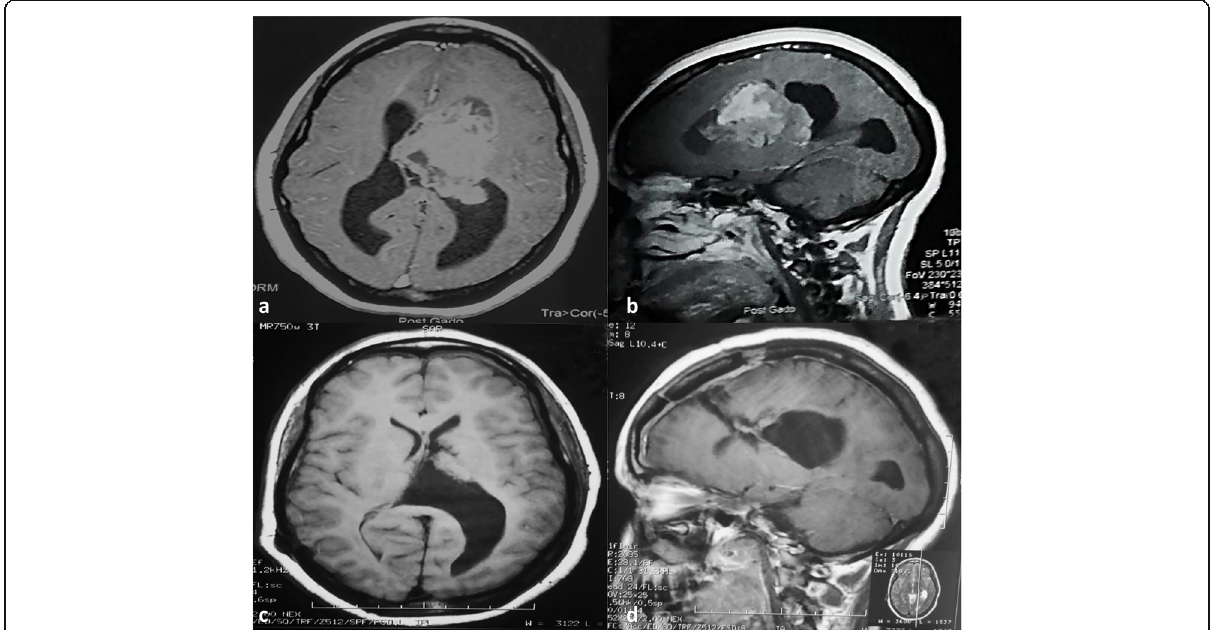
Fig. 3 A large intraventricular central neurocytoma in a 33-year-old lady. a , b The preoperative axial and sagittal contrast-enhanced brain MRI. c ,